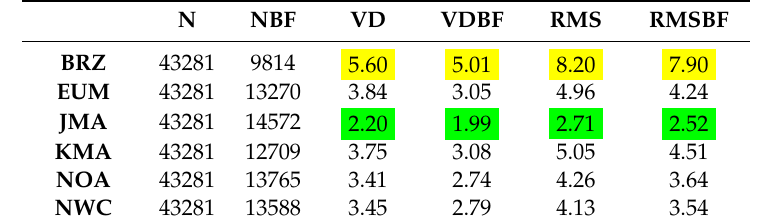
Table 13. Experiment 2: Comparison of collocated AMVs, with QINF >= 80%, to NWP analysis winds. (N = Number of AMVs; NBF = Number of AMVs with Best-Fit Pressure Value; VD = Vector Di ff erence for all AMVs; VDBF = Vector Di ff erence for AMVs with Best-Fit Pressure Value; RMS = Root Mean Square Error for all AMVs; RMSBF = Root Mean Square Error for AMVs with Best-Fit Pressure Value. The extremes for each category are highlighted; in yellow, the worst value, and in green, the best value.